Question: Summarize what this figure shows in one sentence.
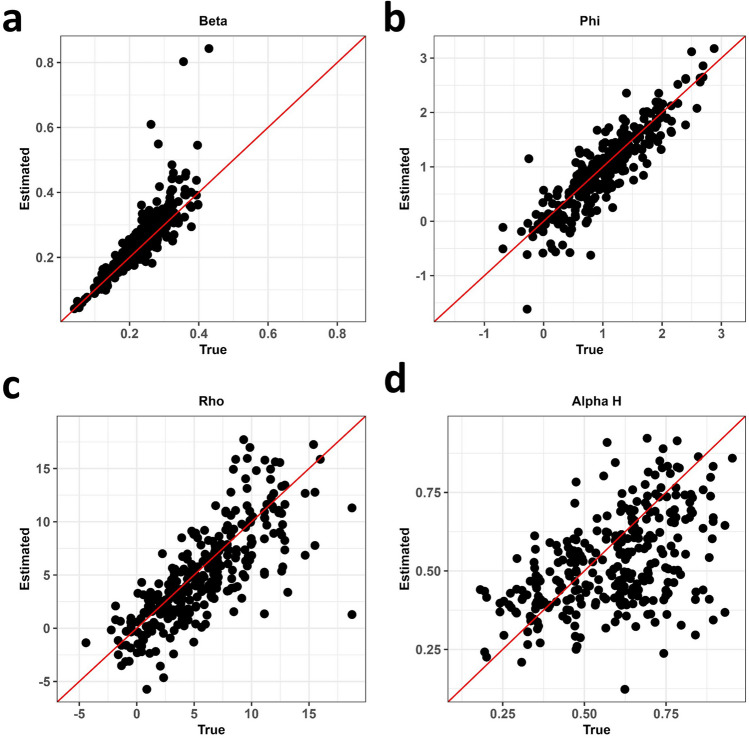
Answer: Parameter recovery. ( a ) Beta (choice stochasticity), ( b ) Phi (exploration bonus), ( c ) Rho (perseveration bonus), ( d ) Alpha H (habit step size). The scatterplots show the correlation of the true data generating parameter values and estimated values after fitting the model to the generated data. Dots correspond to the median of the posterior distribution